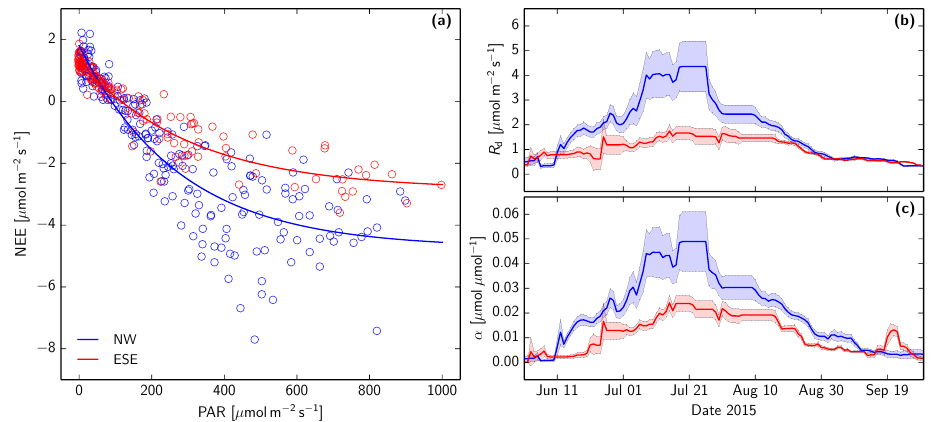
Figure 4. Growing season NEE light response curves based on the ogive optimization method. (a) Examples from the time window around 18 August 2015 from the two distinct footprints. (b) Time series of dark respiration parameters. (c) Corresponding graph for light-use efficiency. The shaded bands indicate the statistical standard error in the